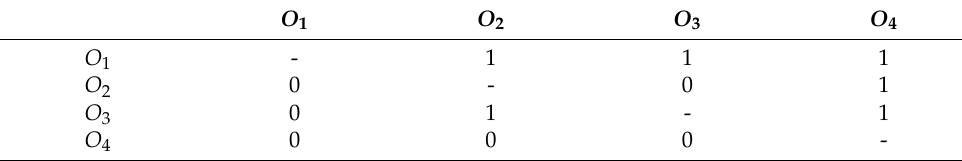
Table 22. The Boolean